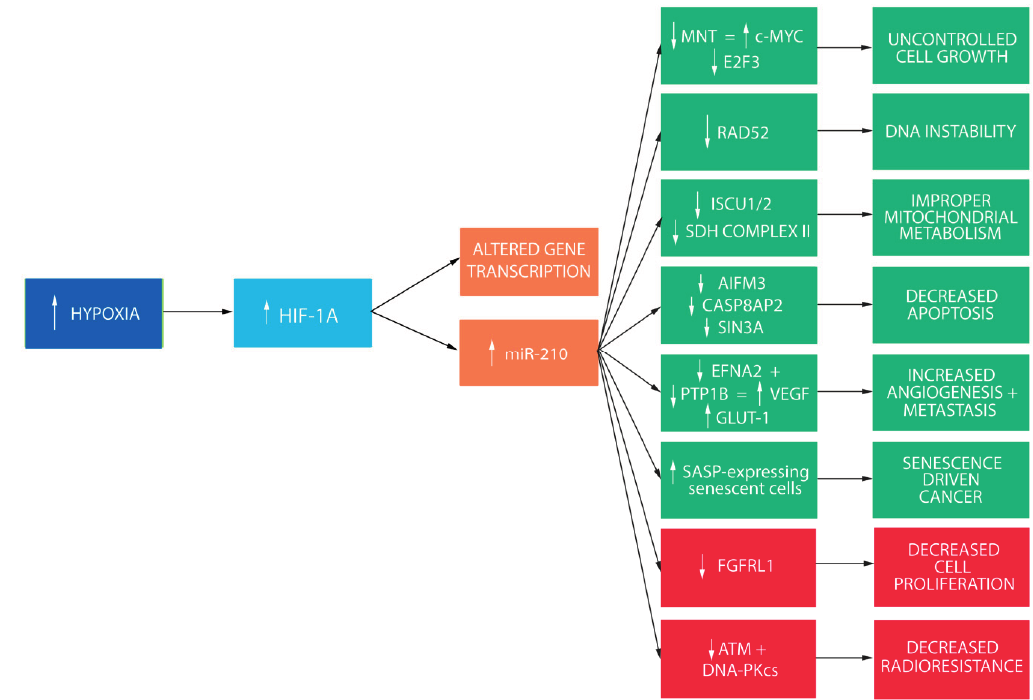
Figure 3. Effects of hypoxia-induced miR-210 on known mRNA targets. Green boxes indicate miR-210 targets that promote oncogenic activity. Red boxes indicate miR-210 targets that promote tumor